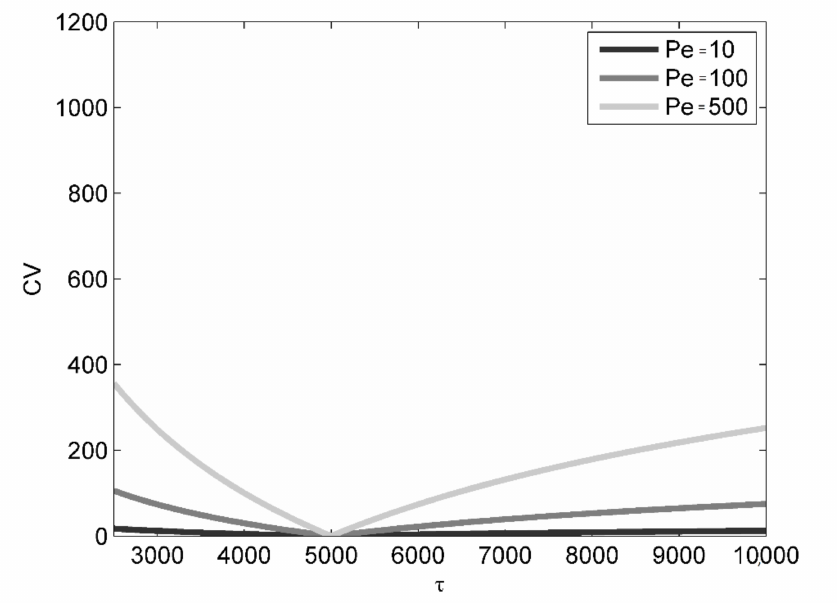
= 1. CV is the concentration Y